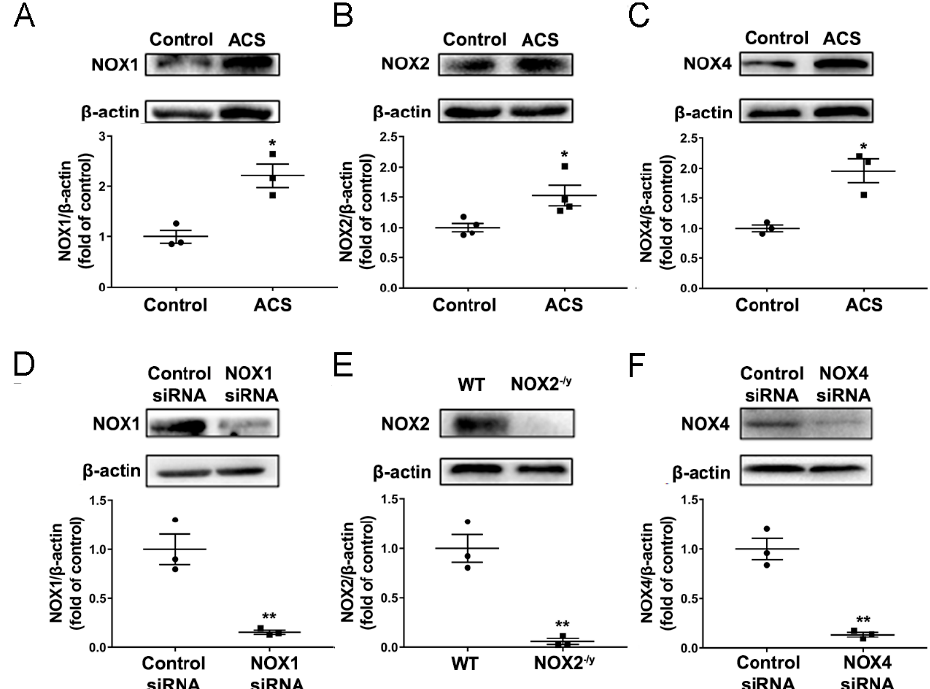
Figure 2. Upregulation of NOX1, NOX2, and NOX4 in ACS exposed mouse lungs; and reduced expression of NOXs in mice genetically silenced for each isoform . Mice were subjected to CS or filtered air for 1 h and then harvested at 6 h. The protein expression of NOX isoforms NOX1, NOX2, and NOX4 was determined in the lungs of mice exposed to ACS, mice knocked down of NOX1 or NOX4, and NOX2 knockout mice using Western blotting analyses. ( A – C ) Representative Western blots and grouped data of NOX1, NOX2, or NOX4 protein expression in ACS exposed mouse lungs. The data indicate that protein expression of NOX1, NOX2, and NOX4 was significantly upregulated in ACS exposed mouse lungs. ( D – F ) Representative Western blots and grouped data of NOX1, NOX2, or NOX4 expression in mice silenced for each isoform. The data indicate that RNAi-mediated NOX1 or NOX4 knockdown significantly attenuated NOX1 or NOX4 protein abundance respectively, while NOX2 was not detected in the lungs of NOX2 − /y mice. All data are presented as Mean ± SEM, n = 3–4. * p < 0.05, ** p < 0.01 vs. air exposed control group.